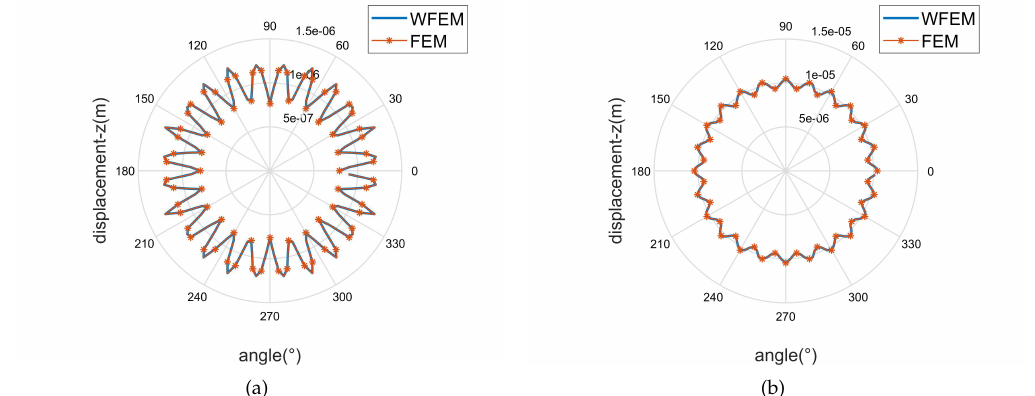
Figure 6. Axial displacement of cross-profiles 1 and 2 calculated in WFEM and